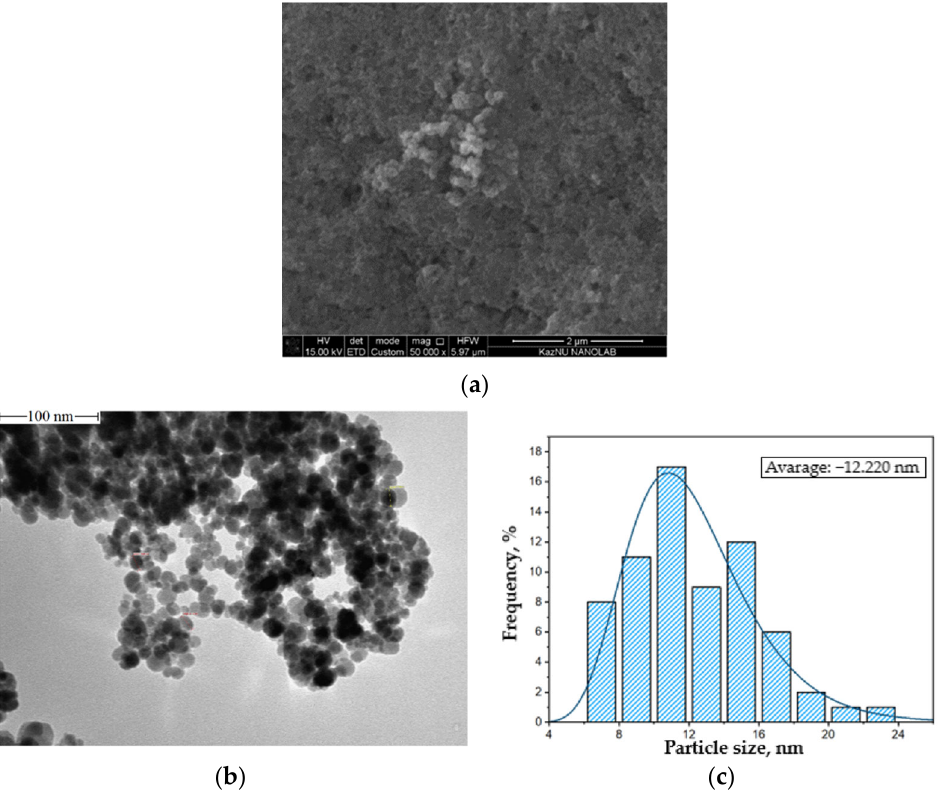
Figure 2. Characterization of magnetite nanoparticles: ( a ) SEM image; ( b ) TEM image; ( c ) particle size distribution based on TEM.